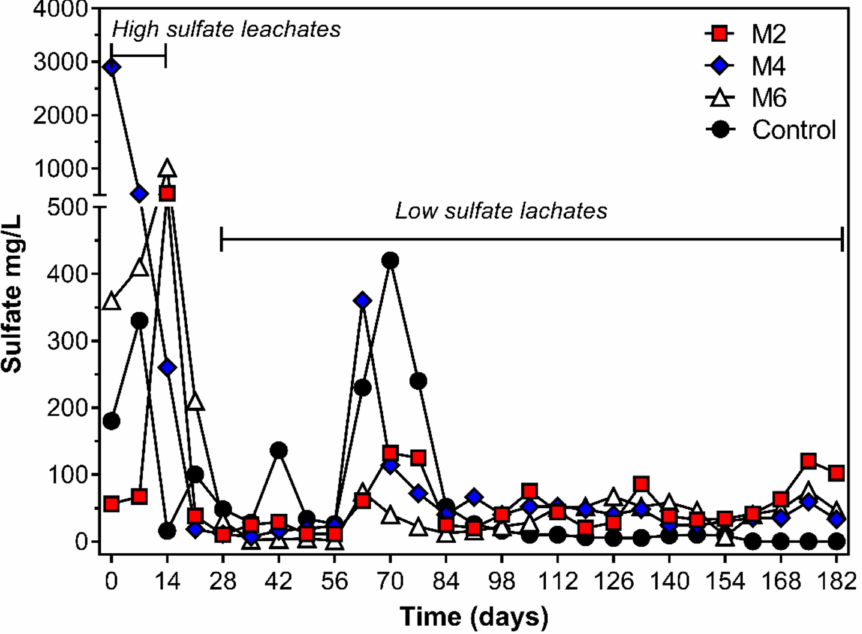
Figure 4. Sulfate evolution over time in the humidity cells tests for paste-tailing